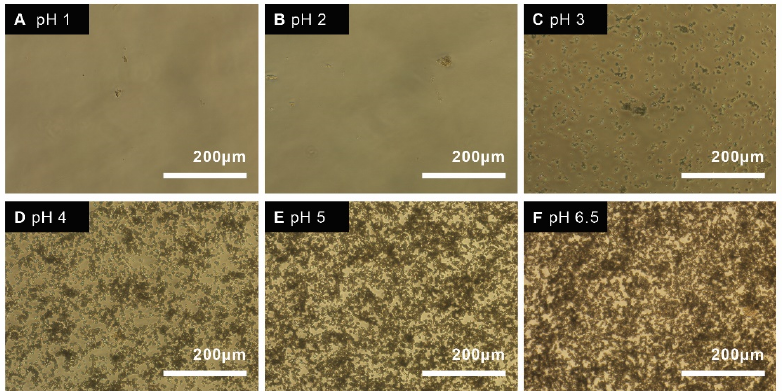
Figure 5. Microscope image of 1 mg/mL particles in acidified DMEM cell media, incubated in 37 °C at different pH; pH 1 ( A ), pH 2 ( B ), pH 3 ( C ), pH 4 ( D ), pH 5 ( E ), and pH 6.5 ( F ) at T = 0 h. However, the pH must remain close to physiological pH (7.4) for cell studies, there ‐ fore the rate of dissolution was determined for different pH close to 7.4 that allowed for release and cell survival (Figure 6). The amount of dissolved particles was quantified by were fully dissolved after 1 h at 0.1 mg/mL at pH 5 and 6.